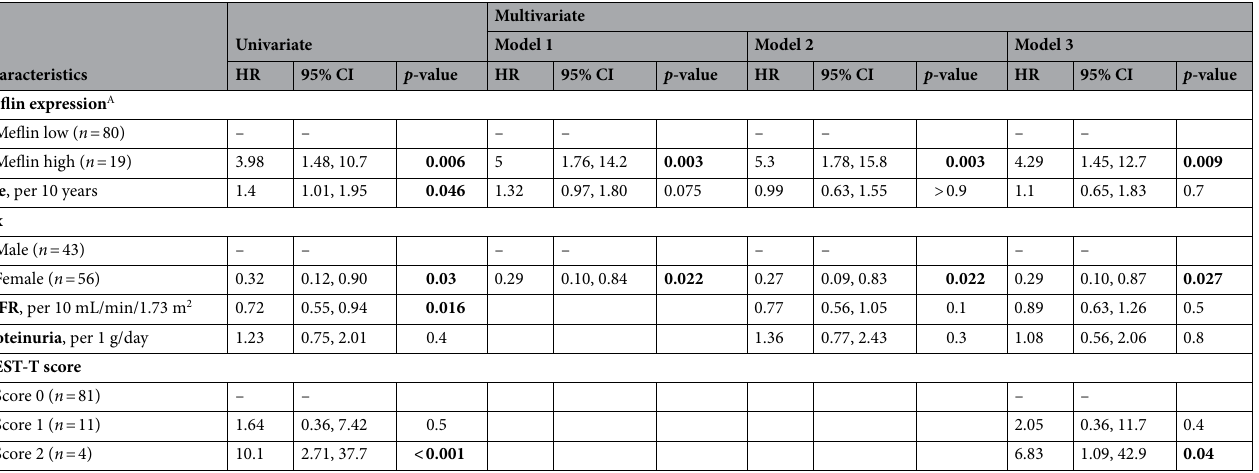
Table 1. Cox proportional hazards models for 99 patients with IgAN. HR hazard ratio, CI confidence interval, eGFR estimated glomerular filtration rate. A Meflin low, Overall Meflin score = 0, 1, 2; Meflin high, Overall Meflin score = 3. Significance values are given in